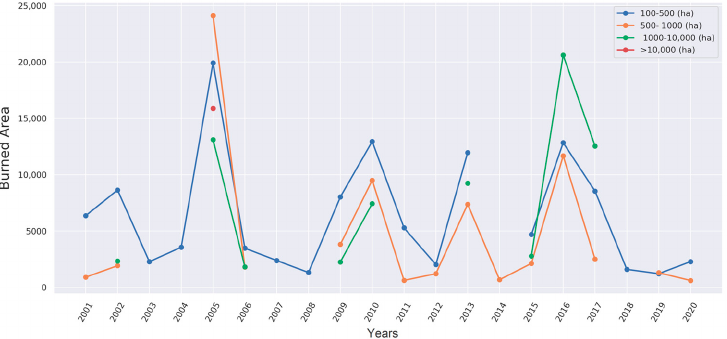
Figure 9. Total burnt area per year and per class. The blue line represents the annual total for the 100-500 ha class; in orange is the 500-1000 ha class; in green is the 1000-10,000 ha class; the greater than 10,000 ha class is in red.